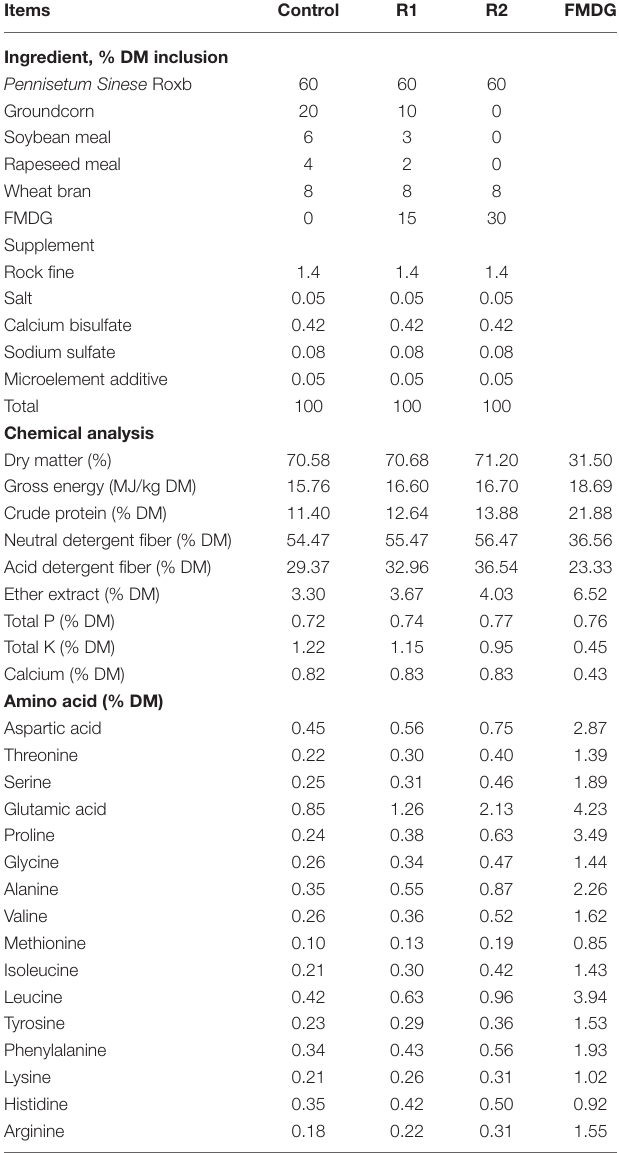
TABLE 1 | Composition and nutritional content of experimental diets varying in levels of fermented-Moutai distillers’ grain